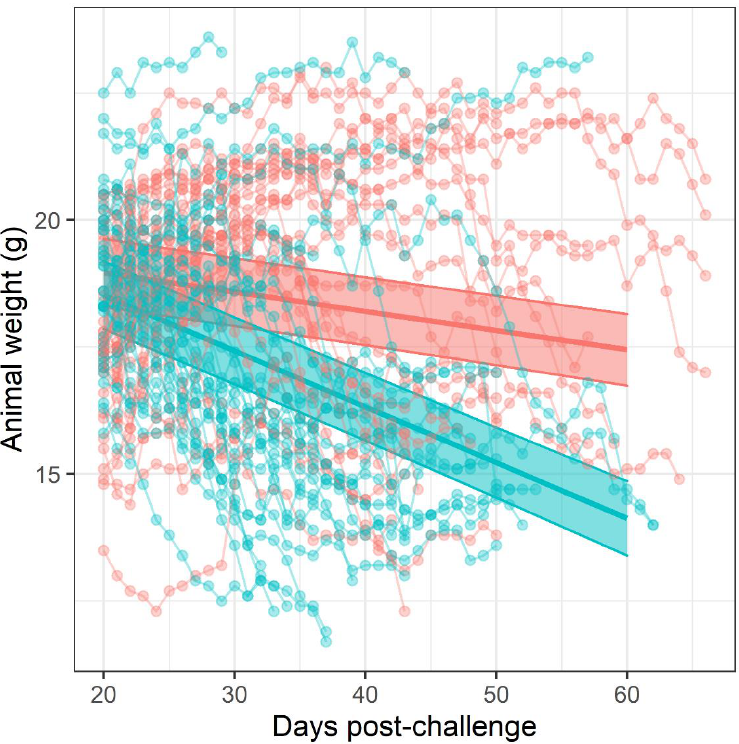
Figure 2. The weight loss profile recorded following antibiotic treatment. Mice were infected with a mean retained dose of 142 CFU of B. pseudomallei by the inhalational route and treated with fin- afloxacin (37.5 mg/kg) every 8 h or co-trimoxazole (78 mg/kg) every 12 h, orally, for 14 days, initiated at 24 h post-challenge. A group of animals were challenged and treated with the vehicle every 8 h. Mice were weighed daily throughout the study. The shaded area represents the 95% prediction in- terval from day 20 post-challenge, the dots represent the original data points. Red – mice treated with finafloxacin, blue – mice treated with co-trimoxazole. Supplemental Figure S2 is a diagnostic plot for this analysis.